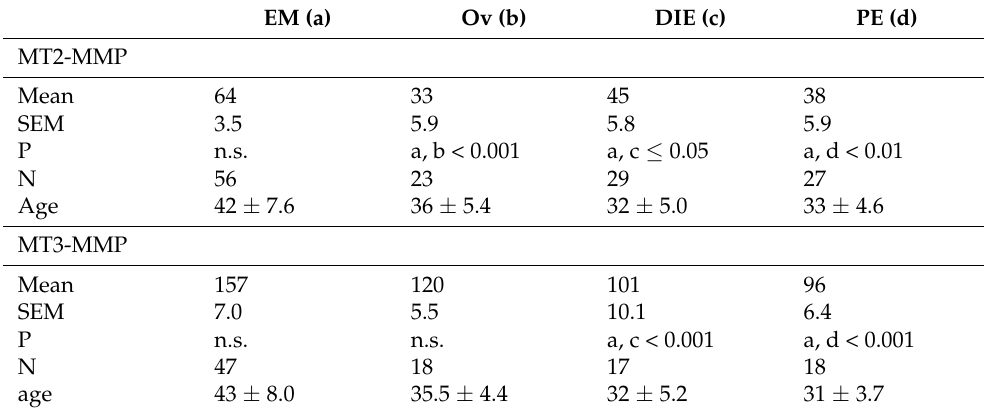
Figure 3. Immunohistochemical detection of MT2-MMP in peritoneal (PE, ( A )), deep infiltrating (DIE, ( B )), and ovarian endometriosis (OV, ( C )). Counterstaining was performed with hematoxylin. Magnification ( A – C ) 20×, scale bars 100 μm. Table 5. Comparison of MT2/3-MMP in eutopic and ectopic endometrium using the HSCORE.